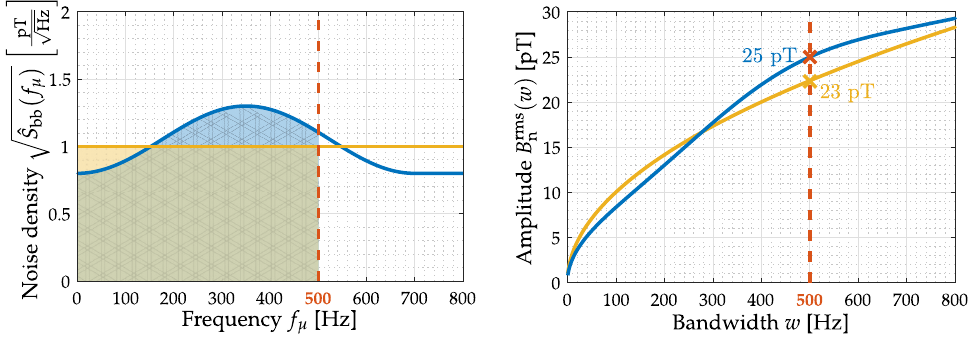
Figure 8. Summation of noise amplitude densities. Two exemplary noise amplitude densities (constant and arbitrary shape) are provided ( a ). Summation is performed from DC up to an increasing upper cutoff frequency to obtain the corresponding RMS value ( b ) for both densities. Assuming a sensor 3 dB cutoff frequency of 500 Hz, the colored areas under curve ( a ) yield RMS amplitudes of − 25 pT and 23 pT, which will vary if a different upper frequency limit is applied ( b